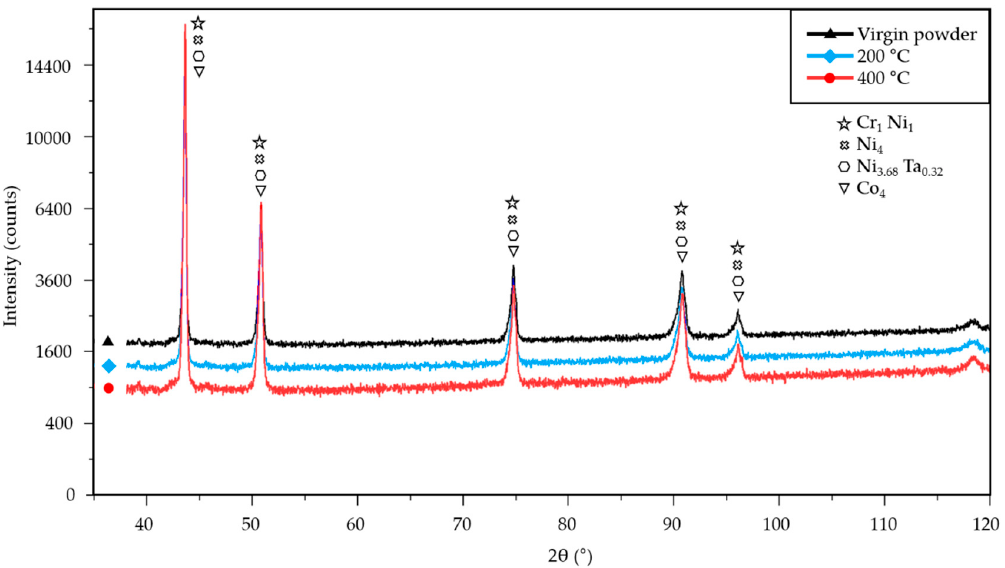
Figure 11. XRD analysis of the IN939 unfused powder in the three conditions: unused virgin powder, powder used at 200 °C, and powder used at 400 °C.